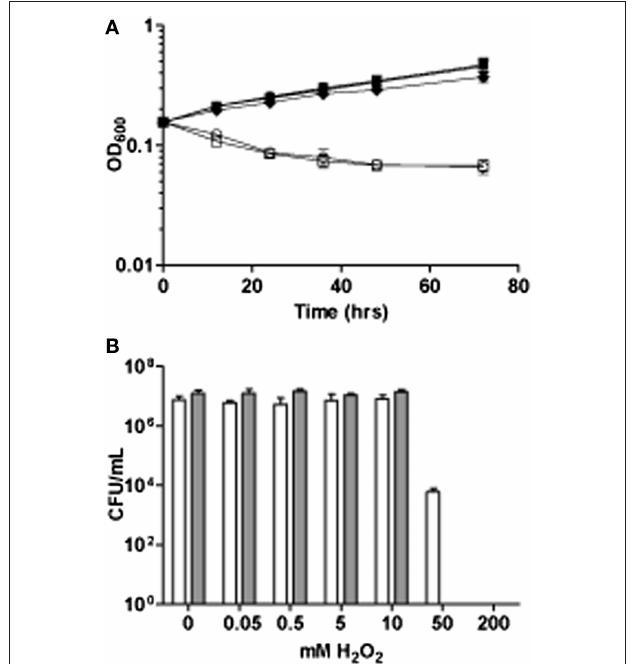
Figure 1 | The effect of H Mtb for 72 h post exposure to H 0.05; filled triangles 0.5, filled downward triangles, 5.0: filled diamonds, 10.0; open circles 50; and open squares 200 mM H monitored by colony forming units 4 h, white bars, and 24 h, gray bars, hours post exposure to a range of H